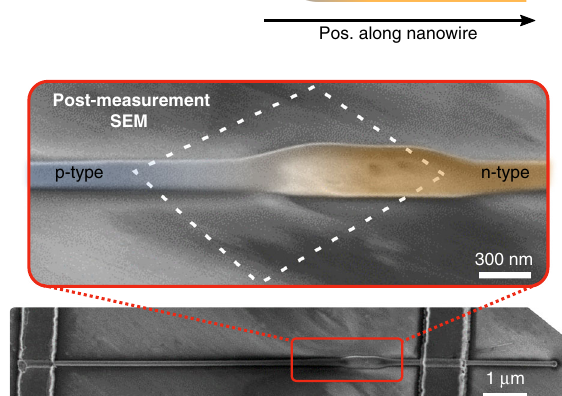
external bias voltages (0 V, black curve in Fig. 5a), revealing the pristine GaAs material. For applied bias voltages of − 1 V (blue curve) and − 2 V (green curve), only a slight increase of the Ga K-edge energy is visible on the n-doped side of the p – n junction. For a bias voltage of − 5 V, however, the Ga K-edge energy on the n-side drastically increases up to almost 10.376 keV (red curve),